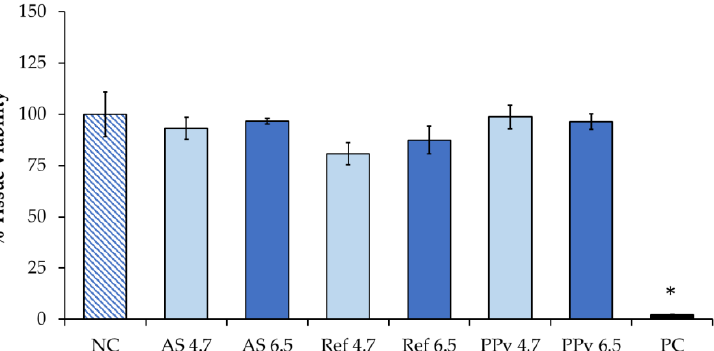
Figure 8. Irritation skin test. EpiDerm™ was exposed to textile extracts from NP-coated (PPy 4.7 and PPy 6.7) and reference textiles (Ref 4.7 and Ref 6.7). Unexposed cells (negative cells, NC) were incubated with PBS 1X and SDS 1% was used as the positive control (PC). Data represent the % of